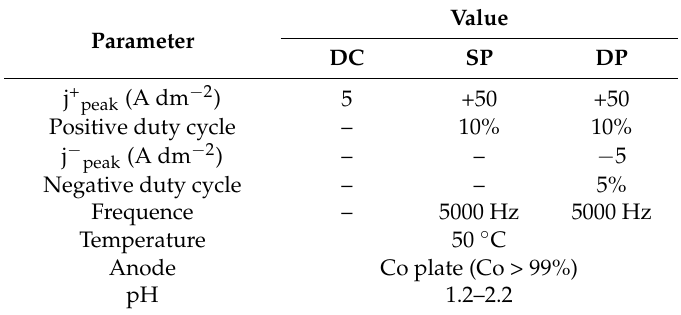
Table 1. Deposition